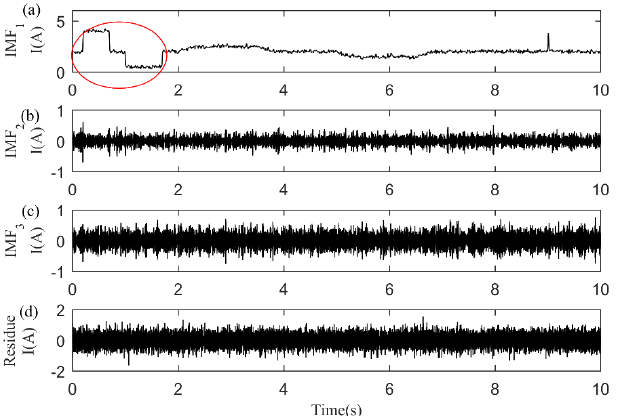
Figure 13. VMD decomposition diagram under the noise of SNR 5. ( a ) IMF 1 component; ( b ) IMF 2 component; ( c ) IMF 3 component; ( d ) Residue.